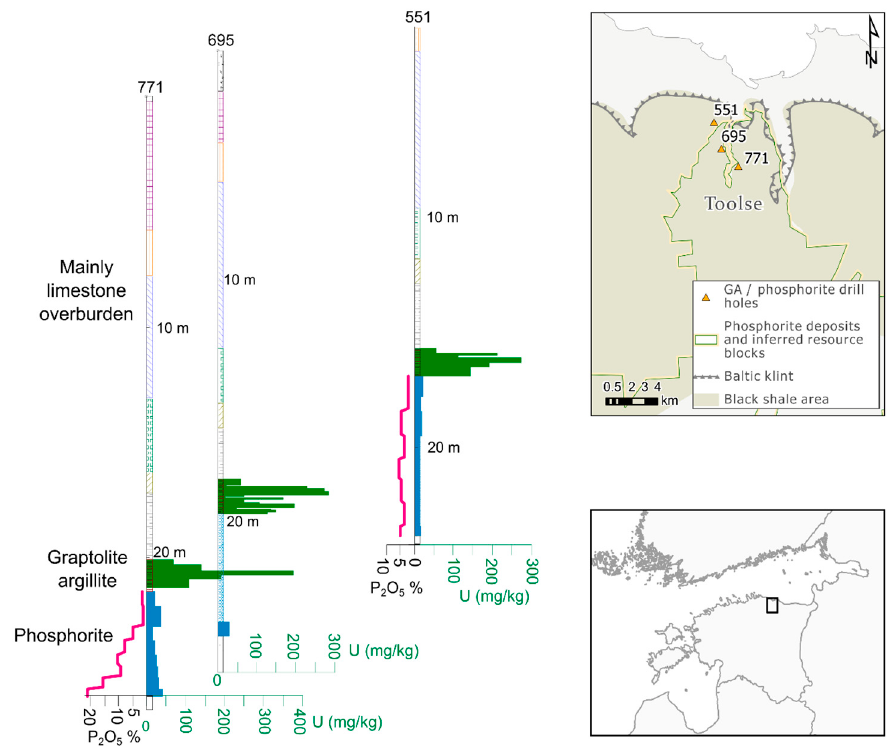
Figure 6. Examples of downhole variations of U concentrations to P 2 O 5 concentration based on drill cores located in the Toolse deposit area. The cores form a south–northerly cross-section. Profiles are depicted vertically and horizontally in scale.